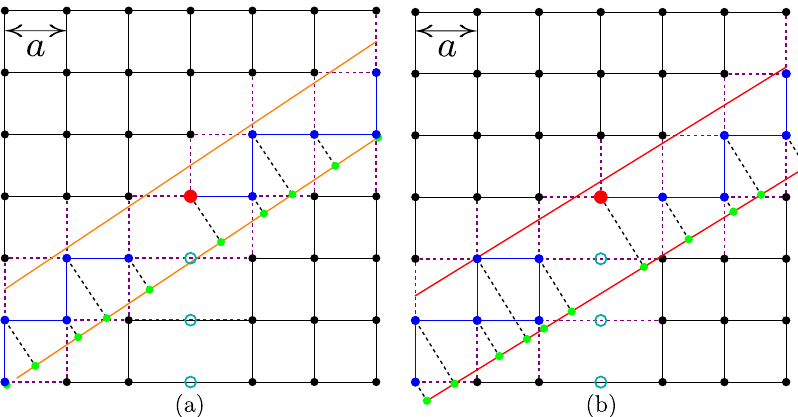
Fig. 3 Construction of a single edge dislocation. Volterra cut-and-paste procedure on a parent 2D square lattice by removing a line of atoms (cyan circles), ending at its center or core (red circle) and subsequently reconnecting the sites living on the edges across it. Projected ( a ) 1D crystal and ( b ) 1D quasicrystal in the presence of a dislocation, with its core falling within the brane. The Burgers vector b = a e x in both cases resides within the hyperplane of the parent crystal. Rest of the details are the same as in Fig.